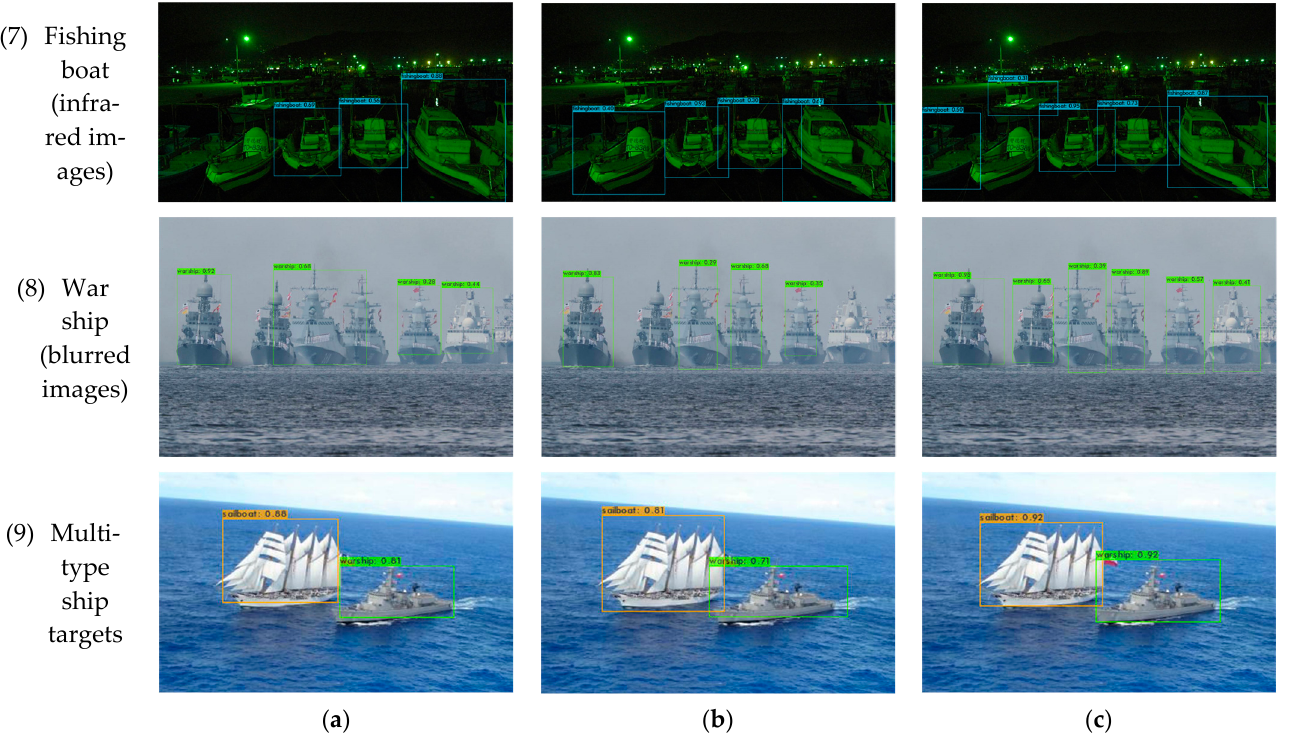
Figure 6. Ship detection results for multiscale targets. ( a ) Original Yolov3. ( b ) Modified Yolov3. ( c ) Modified Yolov3-spp. ( c ) Modified